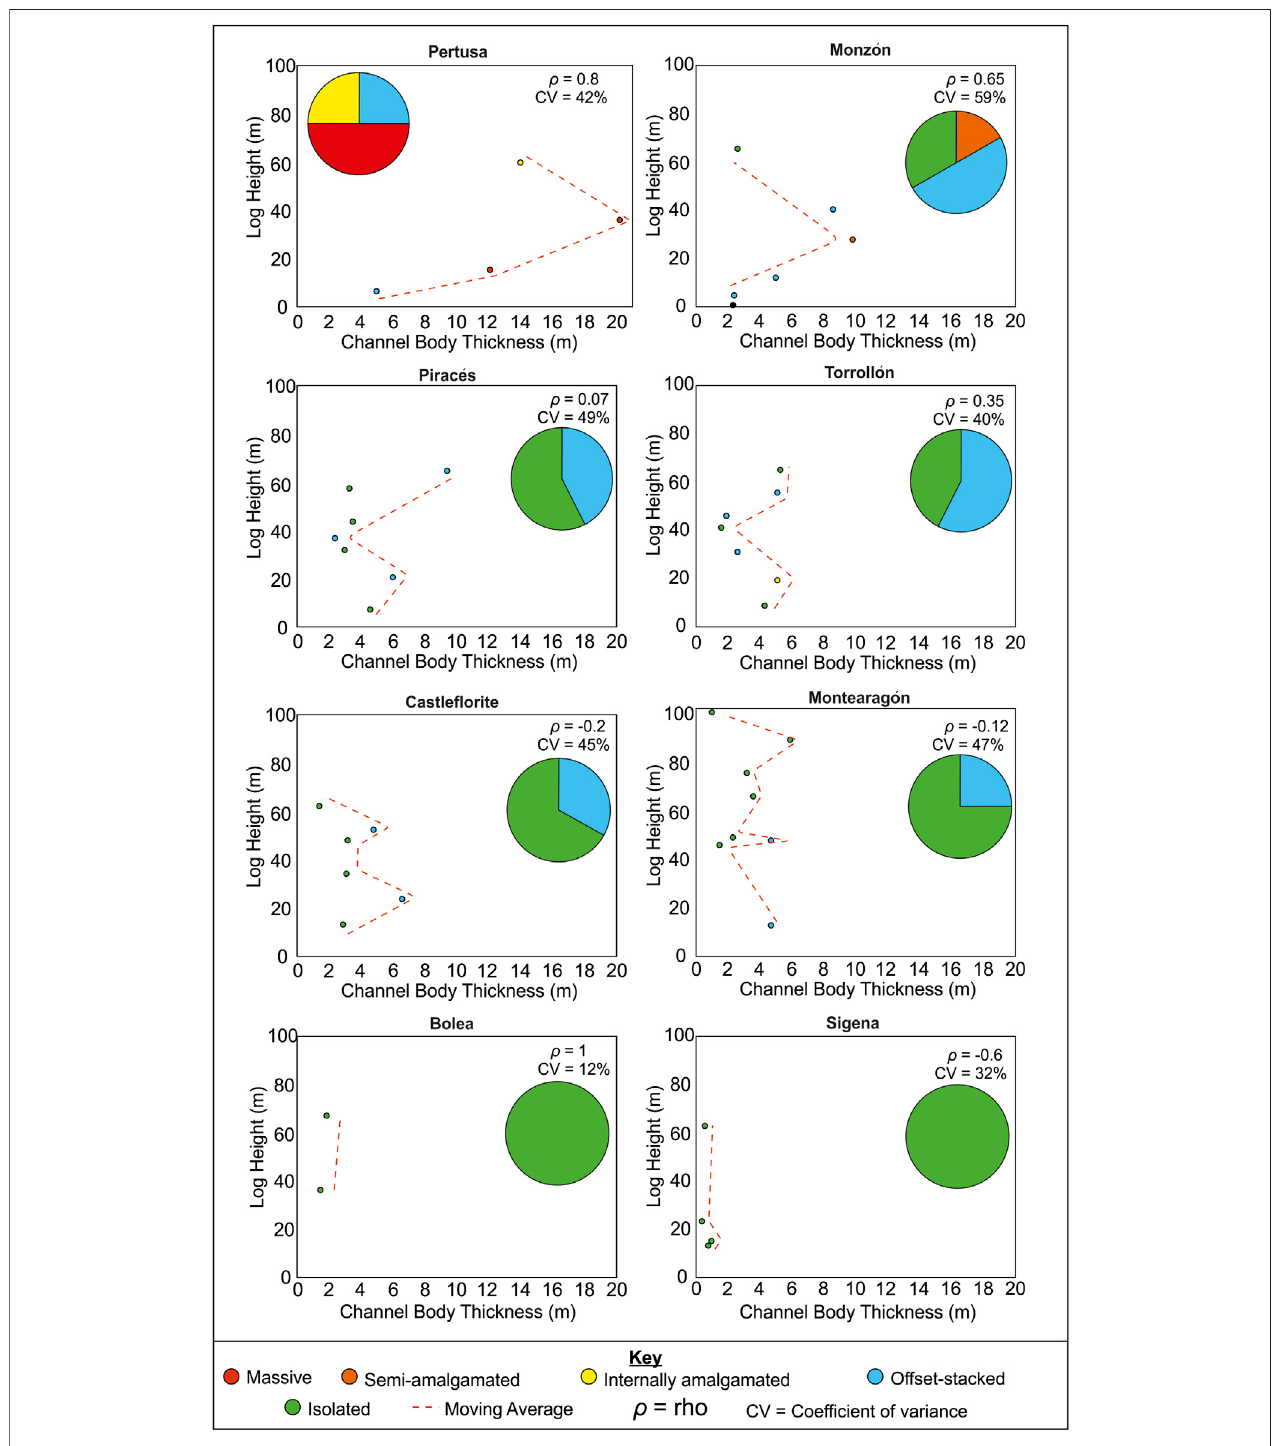
FIGURE 5 | Log height of channel body against channel body thickness for each succession studied. Colored dots represent the interpreted channel geometry present. Moving averages, ϱ and CV are noted for each succession. The pie chart breakdown shows the percentage of channel body geometry types for each locality.